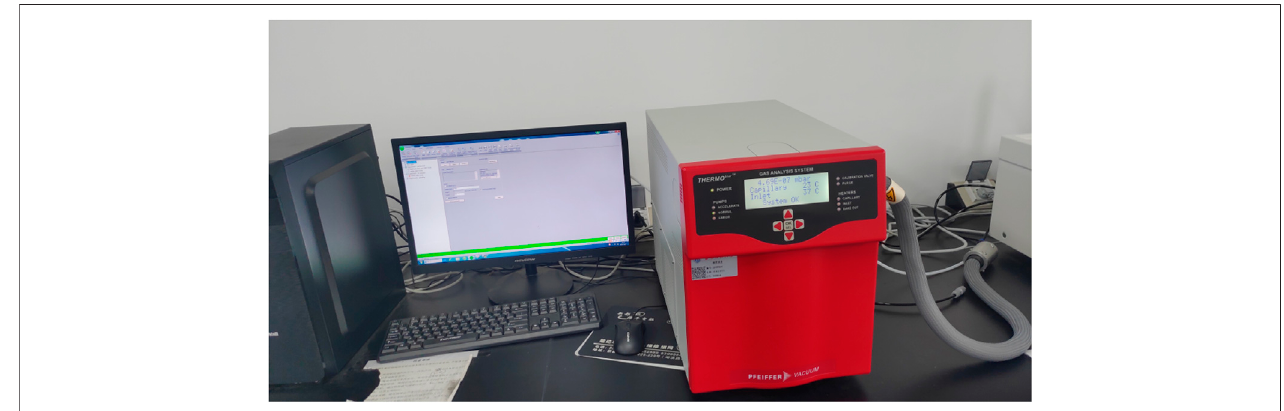
FIGURE 3 | Test result